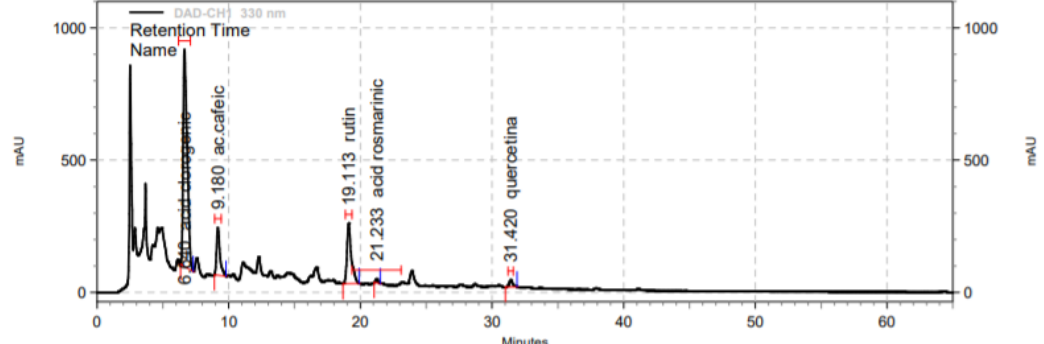
Figure 1. HPLC chromatograms of STOMAPET at 330 nm—hydroxycinnamic acids and flavonoids.